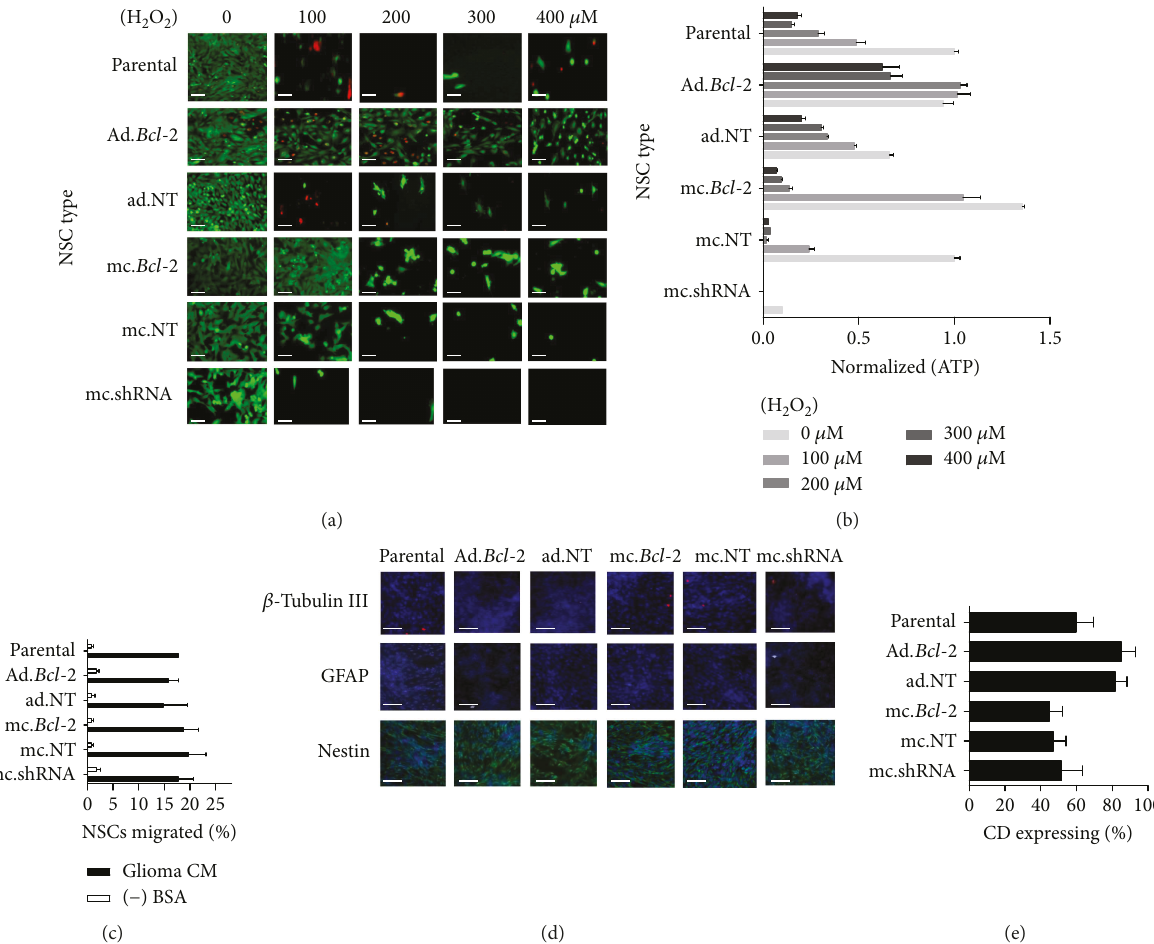
Figure 2: Bioactive e ff ects of Bcl-2 expression in NSCs. (a) Representative fl uorescent images of NSC cultures after a 96 hr incubation in increasing H O doses. Live and dead cells were, respectively, visualized with calcein-AM (green) and ethidium bromide (red). 2 2 (b) Absolute ATP content present in culture was quanti fi ed and normalized with respect to values observed when parental NSCs were cultured with no exogenous H O (c) Tumor tropism of parental and transduced/transfected NSCs in response to U87 2 2. glioma-conditioned media measured in vitro . Data are expressed as percentage of migrated cells, where 100% is 1 × 10 5 . (d) Representative parental and transduced/transfected NSC cultures immunostained for lineage-speci fi c protein. (e) Flow cytometry analysis of E. coli cytosine deaminase expression parental and transduced/transfected NSCS immunostained with